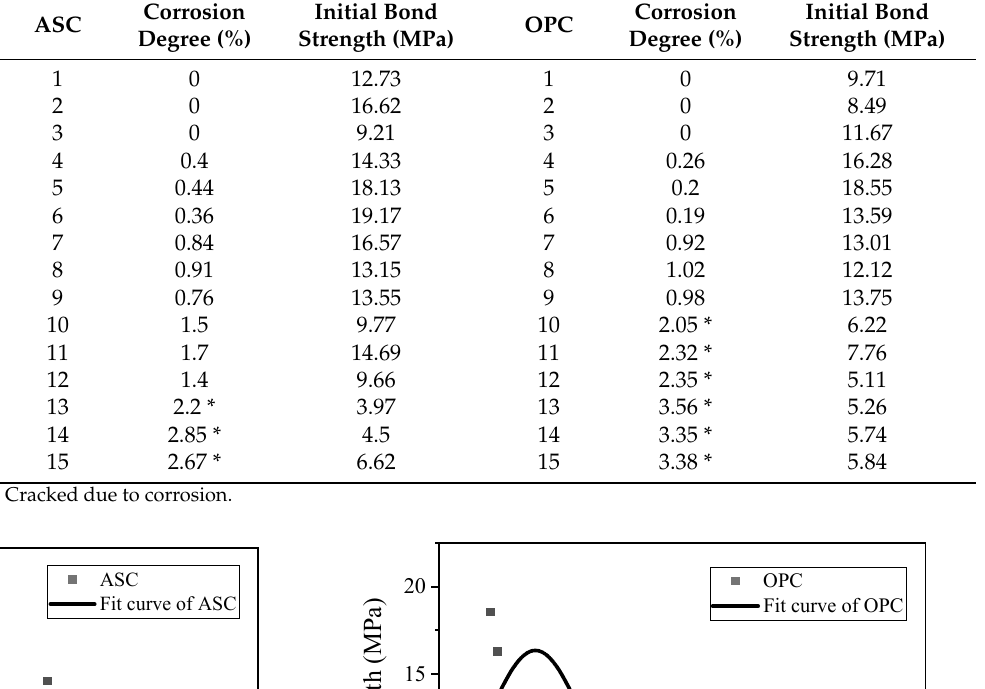
Table 8. Corrosion degree and initial bond strength.